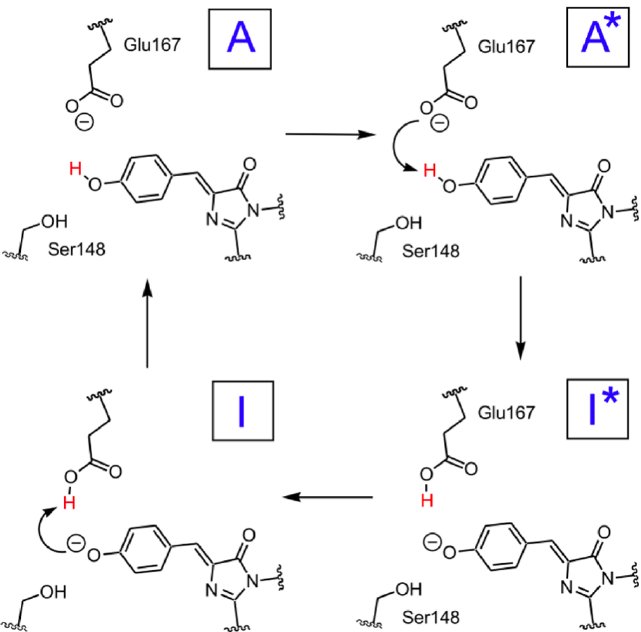
Figure 2. Schematic representation of the hypothesized psamFP488 photocycle, adapted from [19]. Chromophore neutral forms in ground and excited state are labeled as A and A ∗ , respectively, while chromophore anionic forms are respectively labeled as I and I ∗